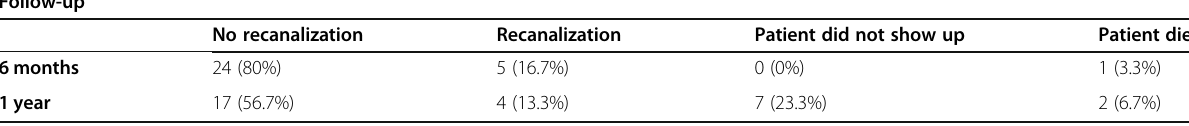
Table 3 Angiographic follow-up